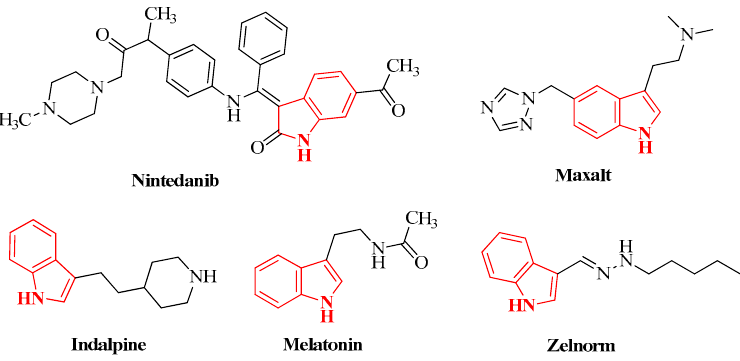
Figure 2. Structures of approved indole-based